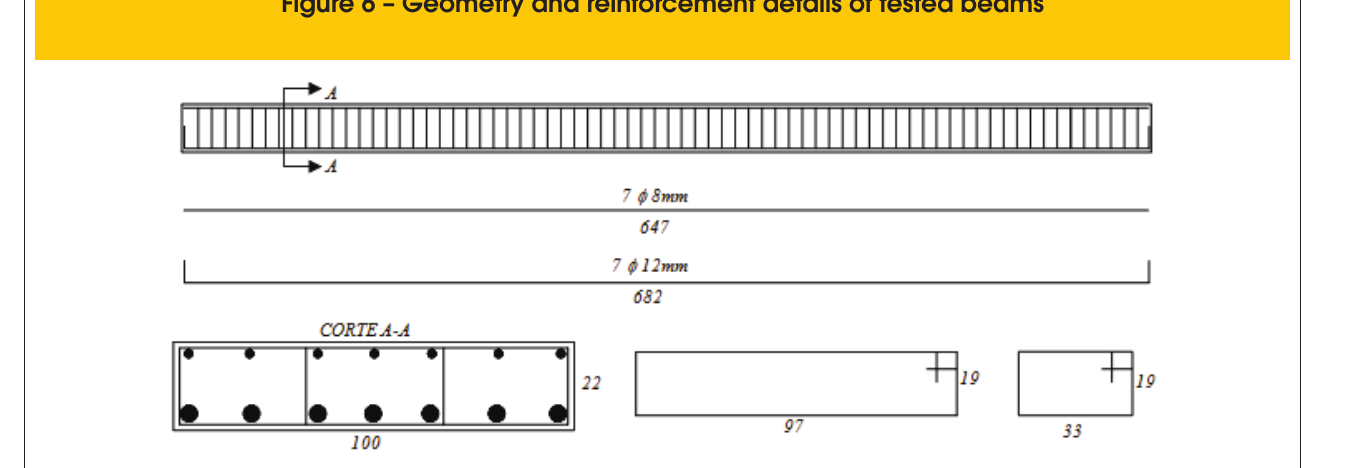
Figure 6 – Geometry and reinforcement details of tested